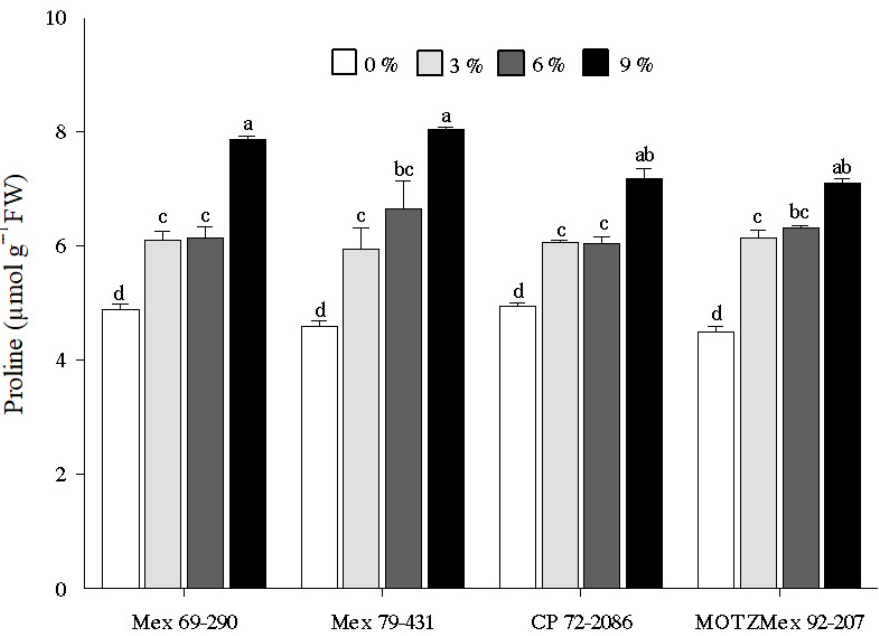
Figure 3. Effect of different concentrations of PEG-6000 on proline content in sugarcane cultivars ( Saccharum spp. Hybrids). Bars above the columns represent the standard error. Different letters above the columns of each subfigure indicate significant statistical differences among treatments (Tukey, p ≤ 0.05).